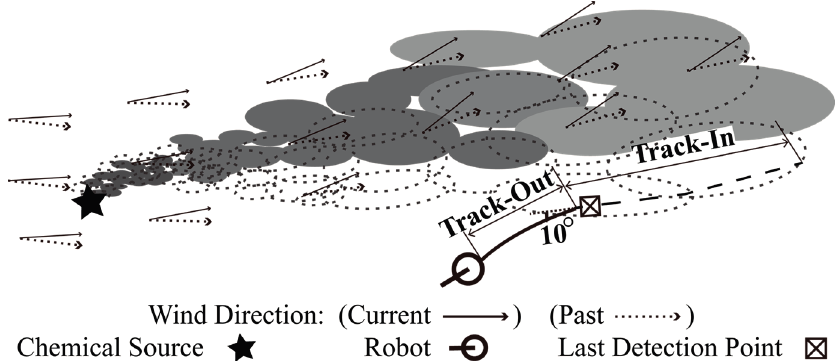
Figure 2. Robot trajectories obtained using BUS in the Track-Out activity. Due to the variation of wind direction, the chemical patches in the plume were carried from their past positions ( i.e. , dotted ellipses) to current positions ( i.e. , grey oblong